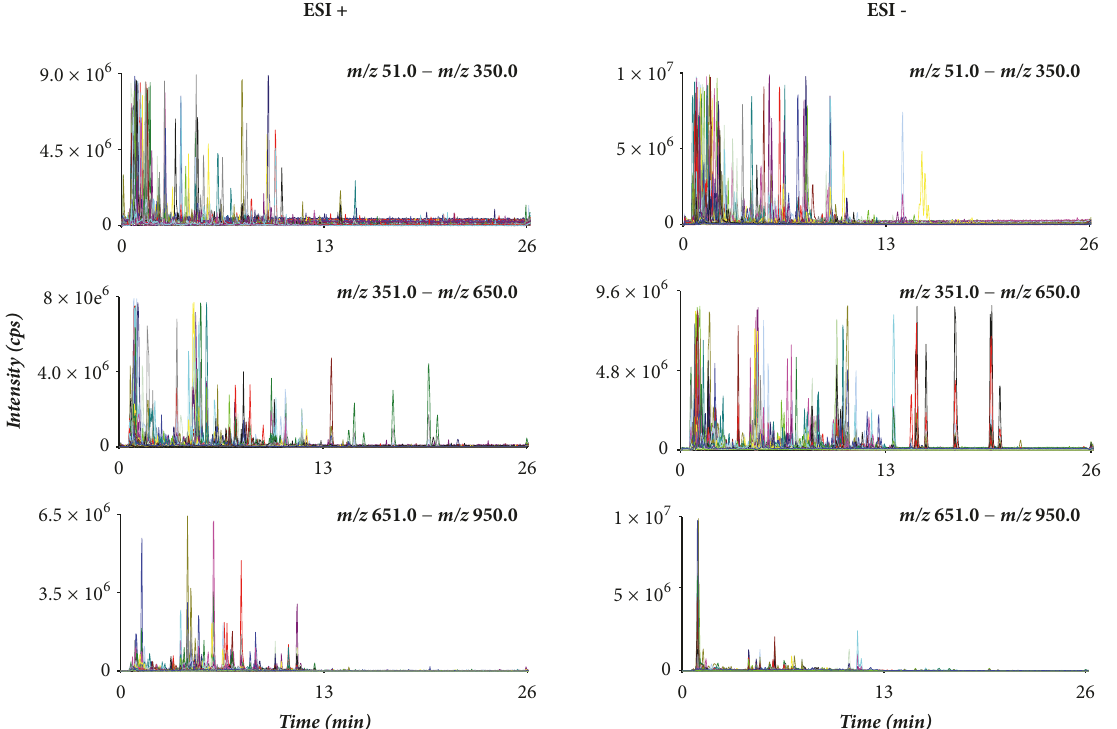
Figure 1: Stepwise multiple-ion monitoring (MIM) chromatogram of